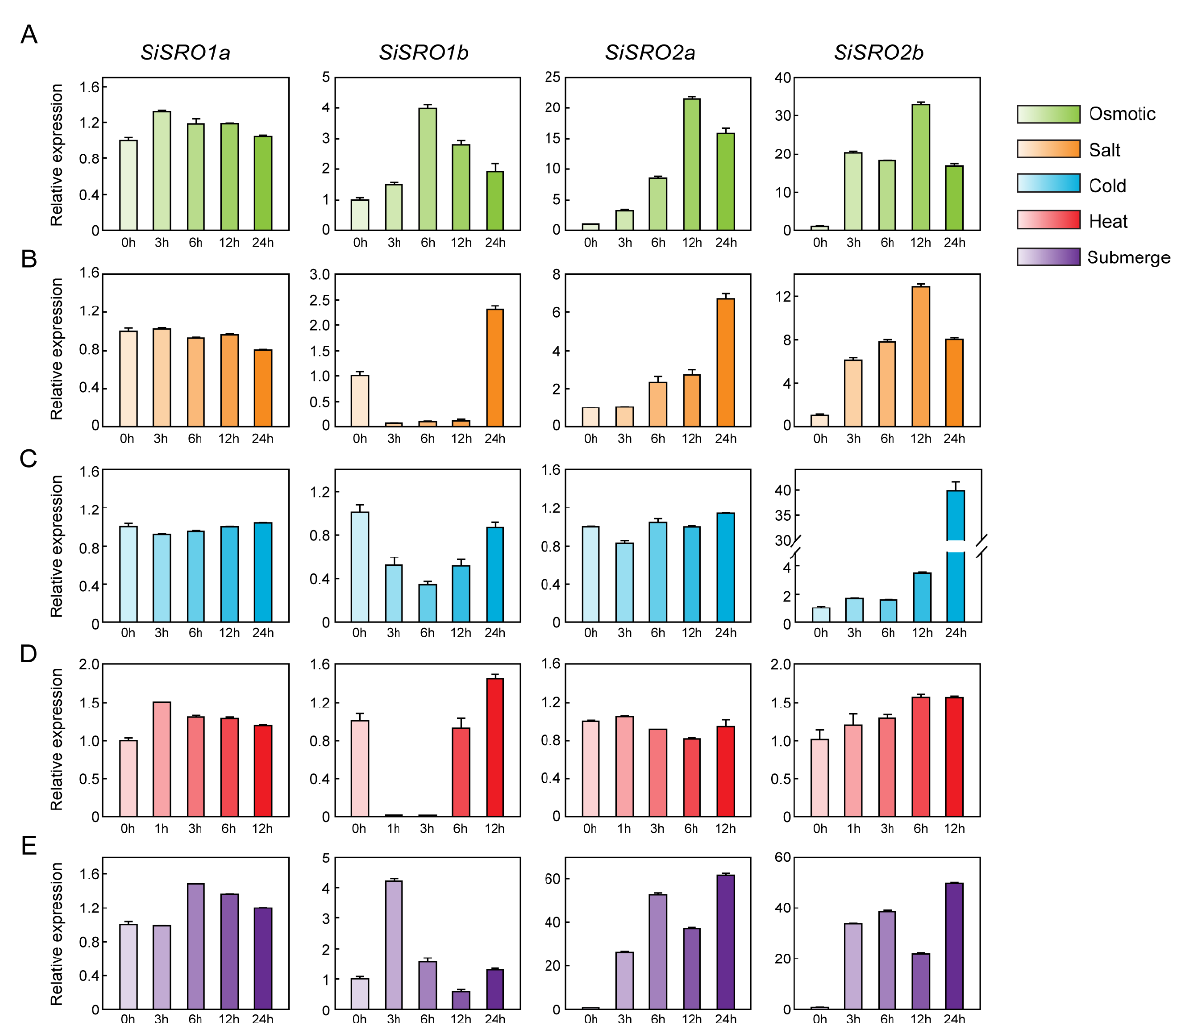
Figure 6. Expression profiles of the SiSRO genes in response to various abiotic stresses. ( A–E ) Expression of SiSRO genes under ( A ) osmotic (15% PEG 6000), ( B ) salt (150 mM NaCl), ( C ) cold (4C), ( D ) heat (42C), and ( E ) submergence treatments. Two-week-old seedlings were subjected to various stresses treatments. Relative expression levels of SiSRO genes were analyzed by qRT-PCR, using sesame SiH3.3 gene as the internal control. Error bars indicate standard deviations (SD) based on three replicates.